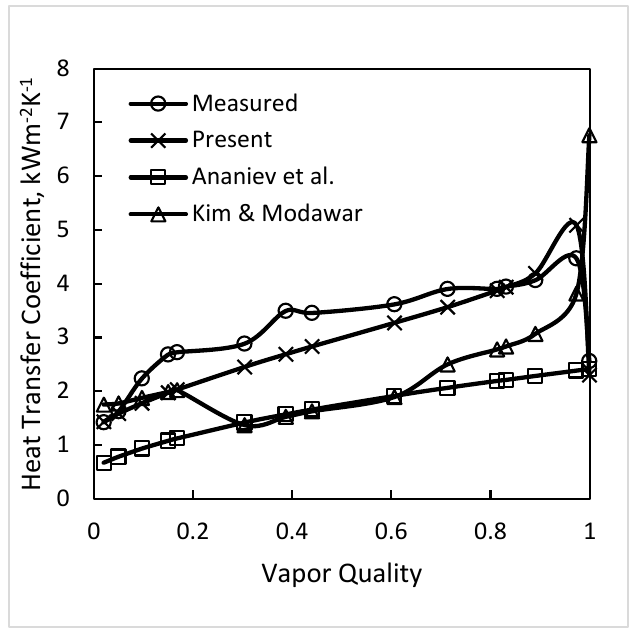
Figure 4. Data of Agarwal and Hrnjak [17] for R-32 compared to some correlations. T SAT = 30 °C, G = 100 kg·m − 2 s − 1 .